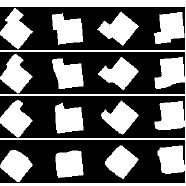
Figure 4. Rectangular building with offsets: 1 row: original, 2 row: 1:10k, 3 row: 1:15k, 4: 1:25k